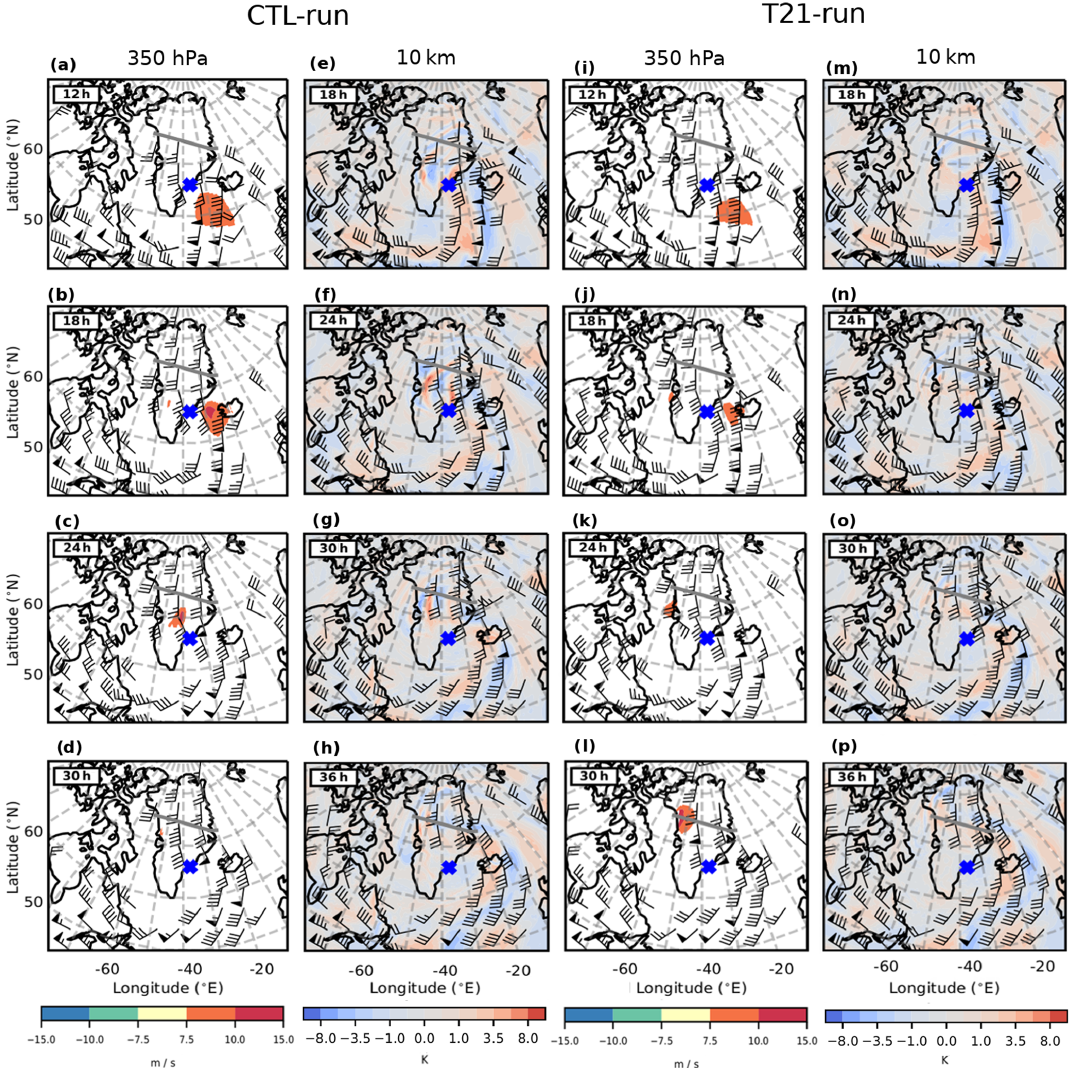
Figure 9. CTL-run (a–h) and T21-run (i–p) cross-stream ageostrophic wind and temperature residuals at different times. The cross-stream ageostrophic wind ( a–d and i–l ) was calculated from pressure levels; hence, here it is depicted at 350hPa ( ≈ 8.1km). The temperature residuals ( e–h and m–p ) were determined based on geopotential heights; hence, this is valid for 10km. The temperature residuals are depicted ≈ 2km higher than the cross-stream ageostrophic wind, as the GW structure forms a complex interference pattern with upward- and downward-propagating GWs within the jet. The temperature residual plots are offset by 6h from the cross-stream ageostrophic wind to allow time for the GWs to propagate to 10km (a vertical group velocity of 200–700mh − 1 indicates vertical propagation of 2km between 3 and 10h). The overlaid wind barbs are as in Fig. 1. The flight path is indicated in grey, and thick black lines represent the coastline. The blue cross indicates the location of the stability discussion in Sect. 3.3. Times (in h) are since model initialisation (on 9 March at 12:00UTC) + xx h (“ xx ” as specified in the top left corner of each